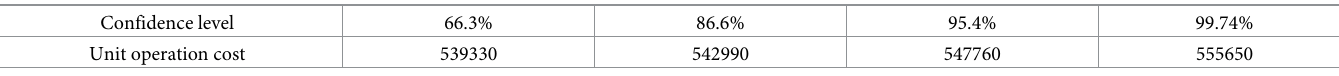
Table 5. Unit operation under different confidence levels under traditional